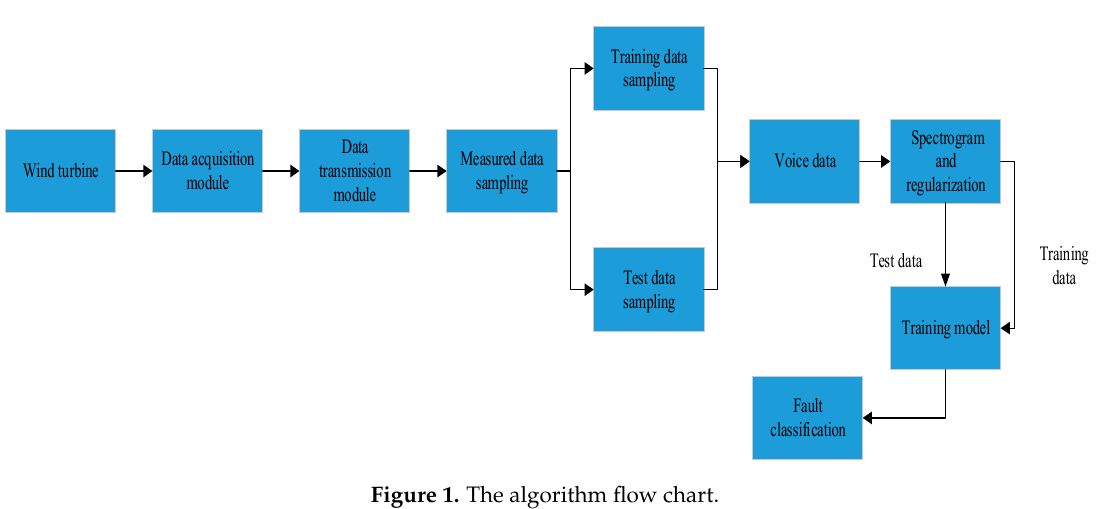
Figure 1. The algorithm flow chart.